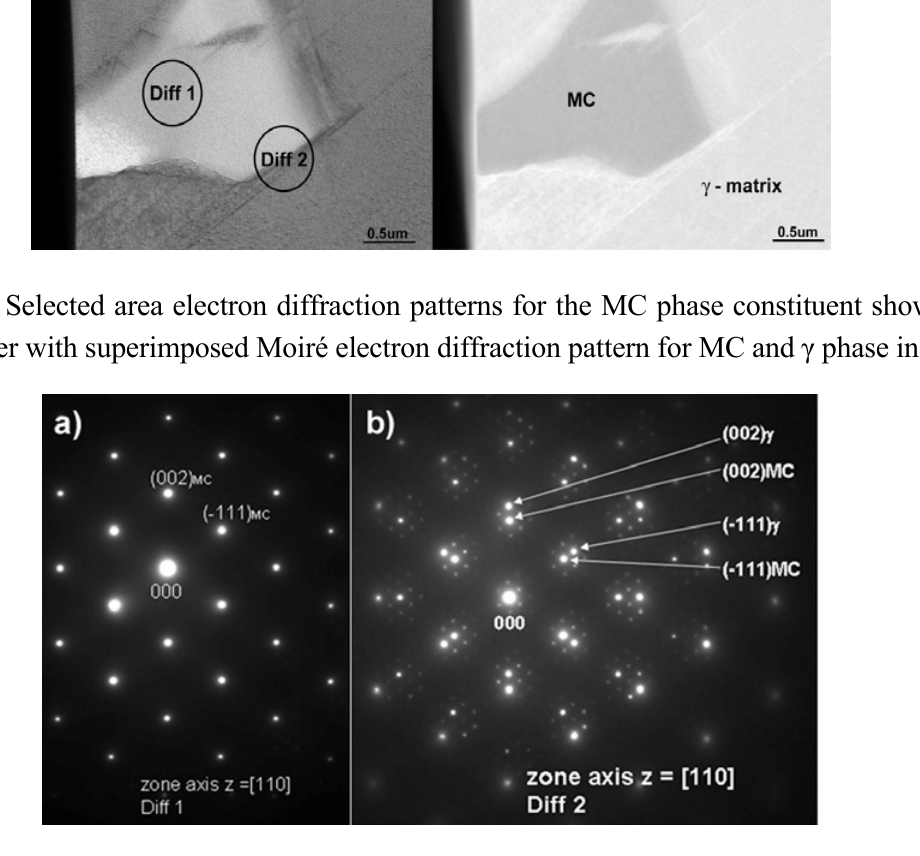
Figure 7. EDS and wave length dispersive X-ray spectroscopy (WDS) patterns for